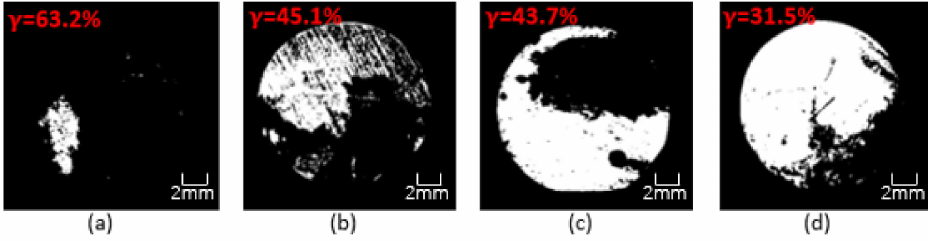
Figure 19. Binary image of each coating in seawater of 60% concentration for 60 days: ( a ) G1; ( b ) G2; ( c ) G3; ( d )